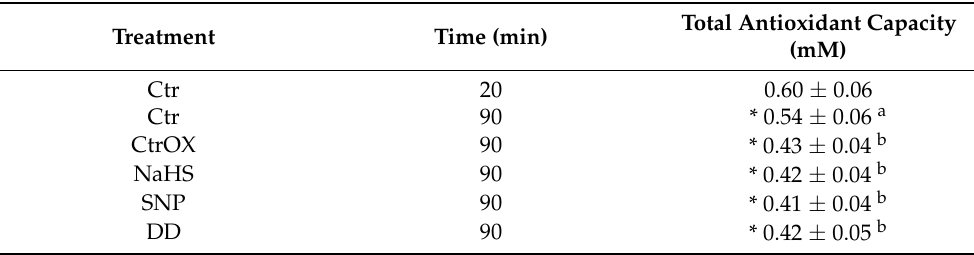
Table 3. The effect of NaHS, SNP, and their combination (DD) on the levels of total antioxidant capacity in different samples of boar spermatozoa under oxidative